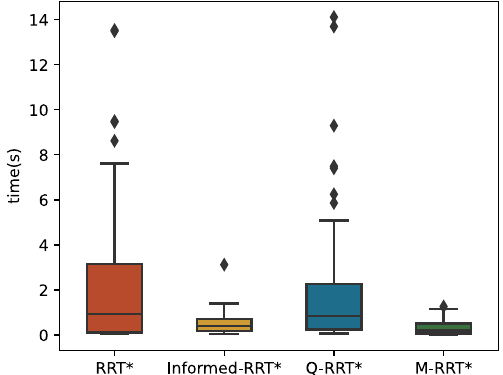
Figure 11. T 5% in the regular environment. Table 2. t init and T 5% of four algorithms in the regular environment.